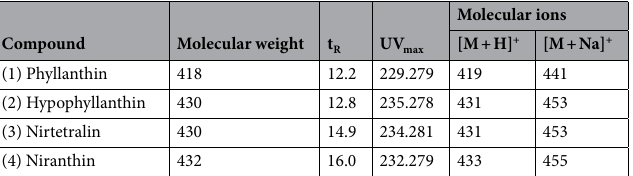
Table 1. Retention time (HPLC–UV), UV spectra, molecular weight and molecular ions of analyzed compounds.